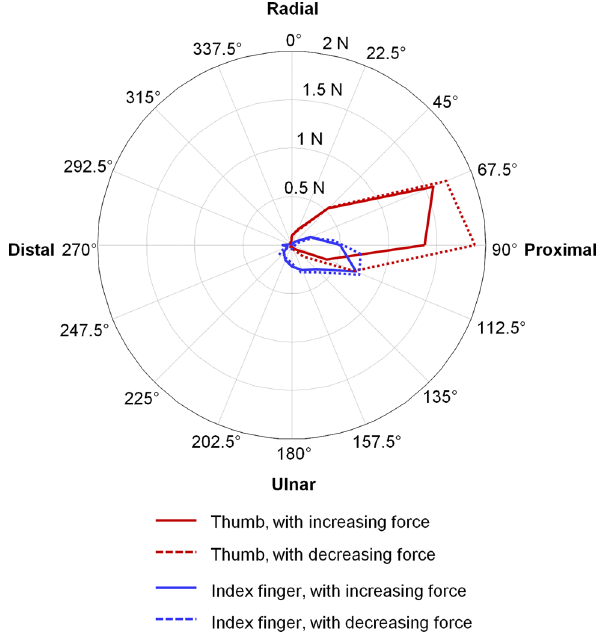
Figure 7. Shear force tuning curves for the thumb and index